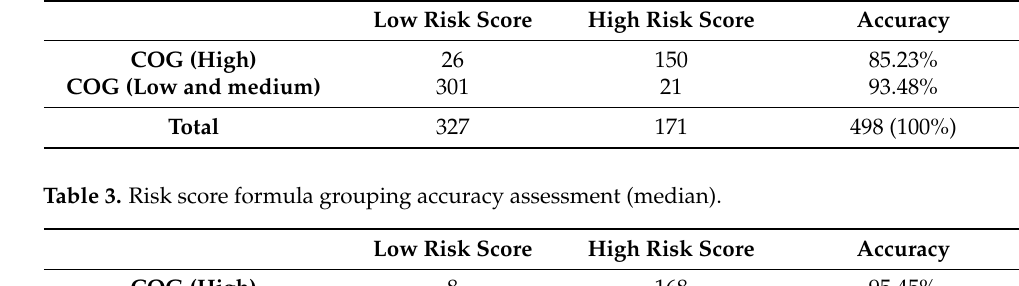
Table 2. Accuracy evaluation of risk score formula grouping (optimal cutoff). Low Risk Score High Risk Score